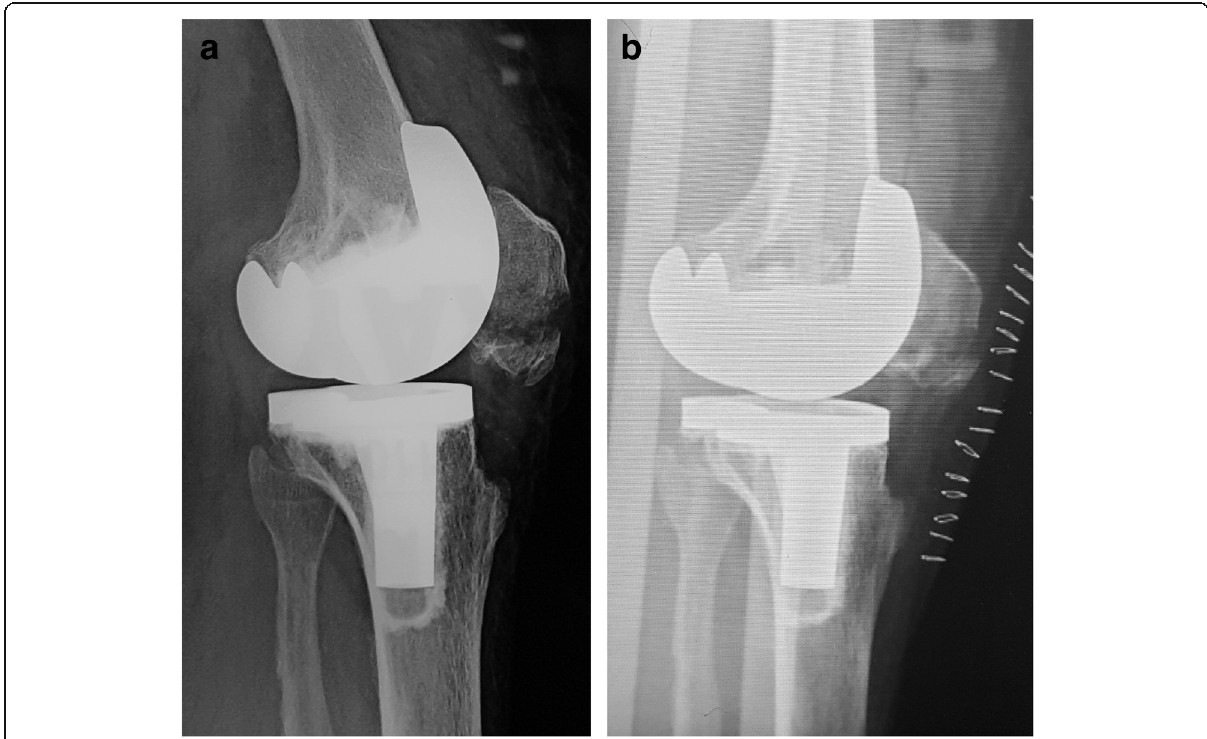
Fig. 2 A 65-year-old female patient who had a PPPF in her right knee (case 2 in Table 1). a Preoperative lateral X-ray shows the displaced and comminuted PPPF with extensor mechanism rupture. b Fixation is achieved with Ethibond polyester